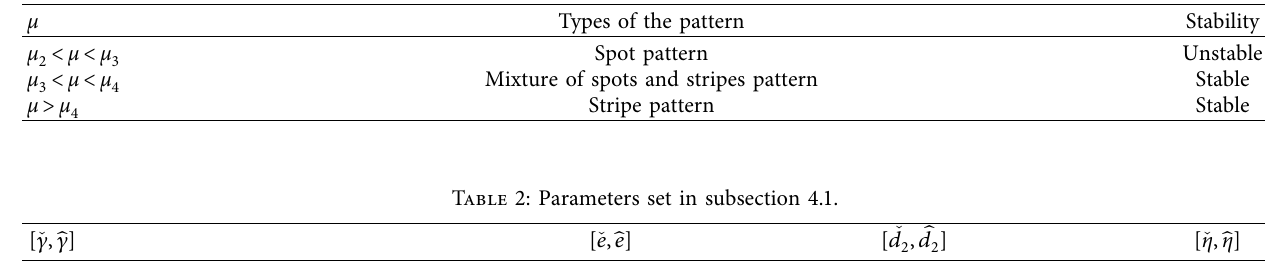
Table 3: Parameters calculated in pattern selection corresponding to diferent values of interval variable q .